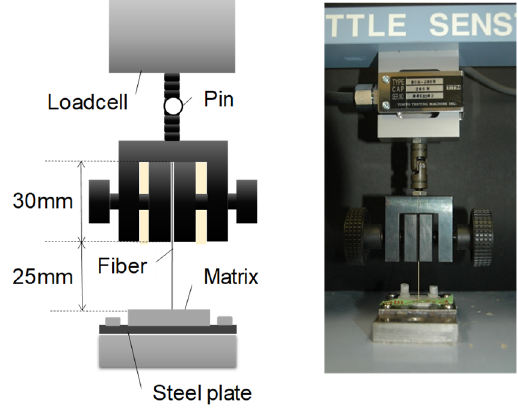
Figure 4. Loading method.